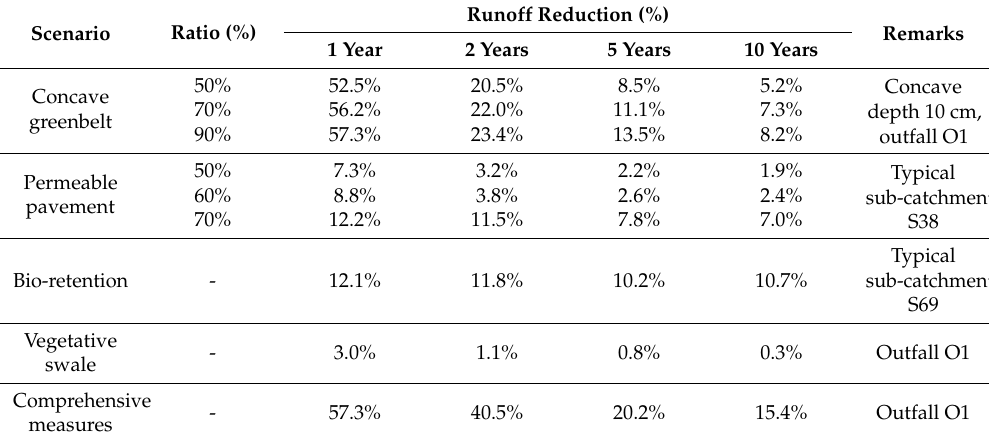
Table 8. Percentage of runoff reduction under different